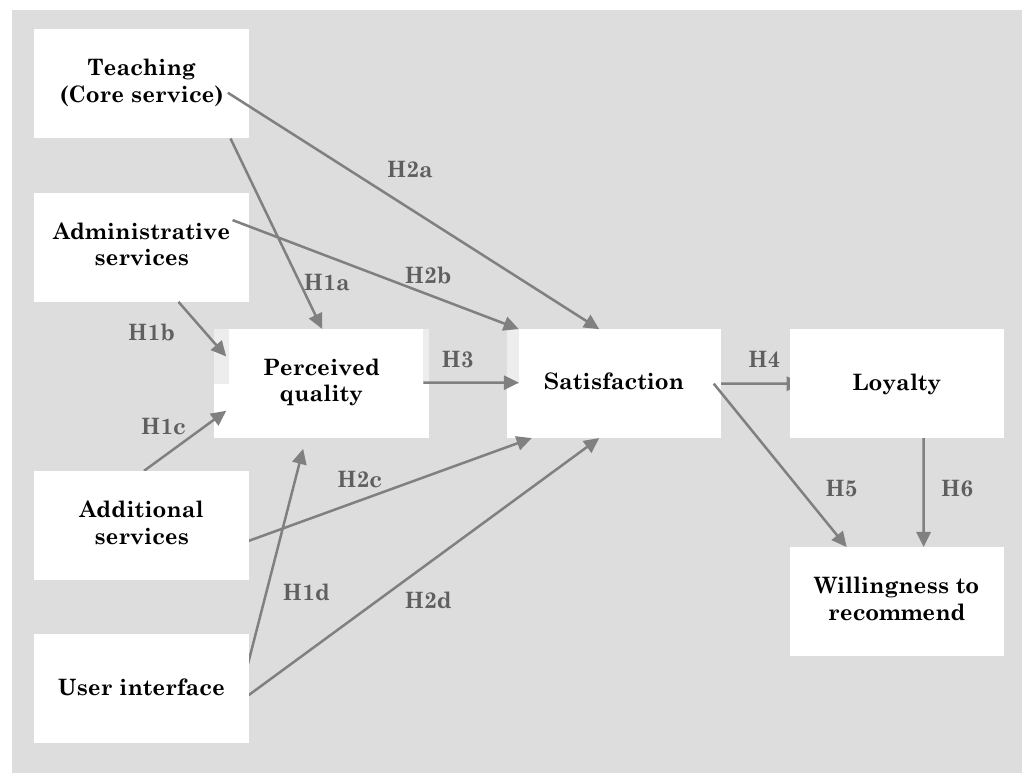
Figure 1 . Structural model showing the relationships between the key